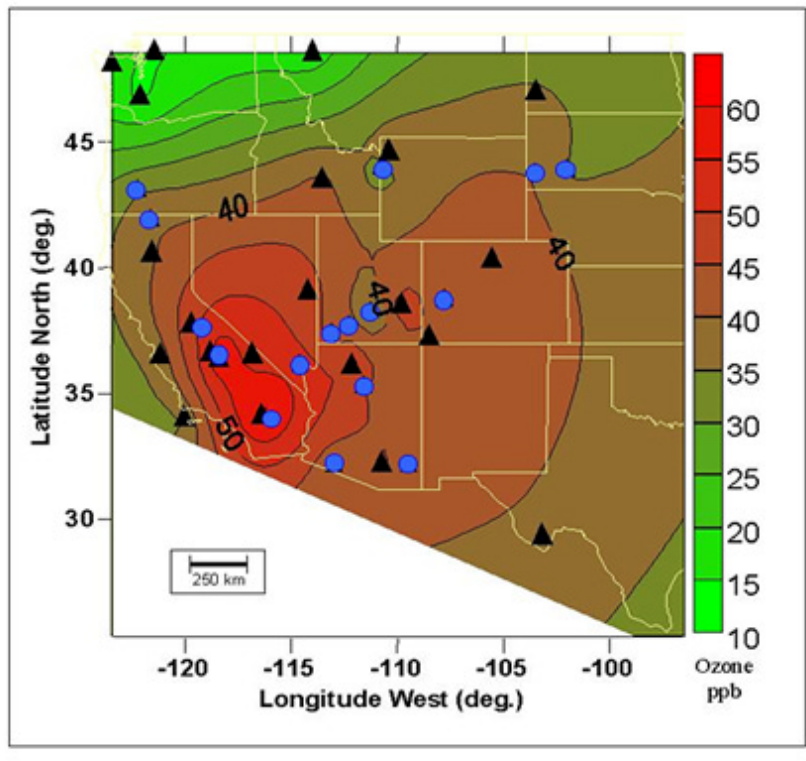
FIGURE 5. Rural ozone concentrations as seasonal averages over the western United States in 1997 based on measurements of passive and active monitors at the national parks marked. Black triangles are continuous analyzer sites and the blue dots are passive sampler